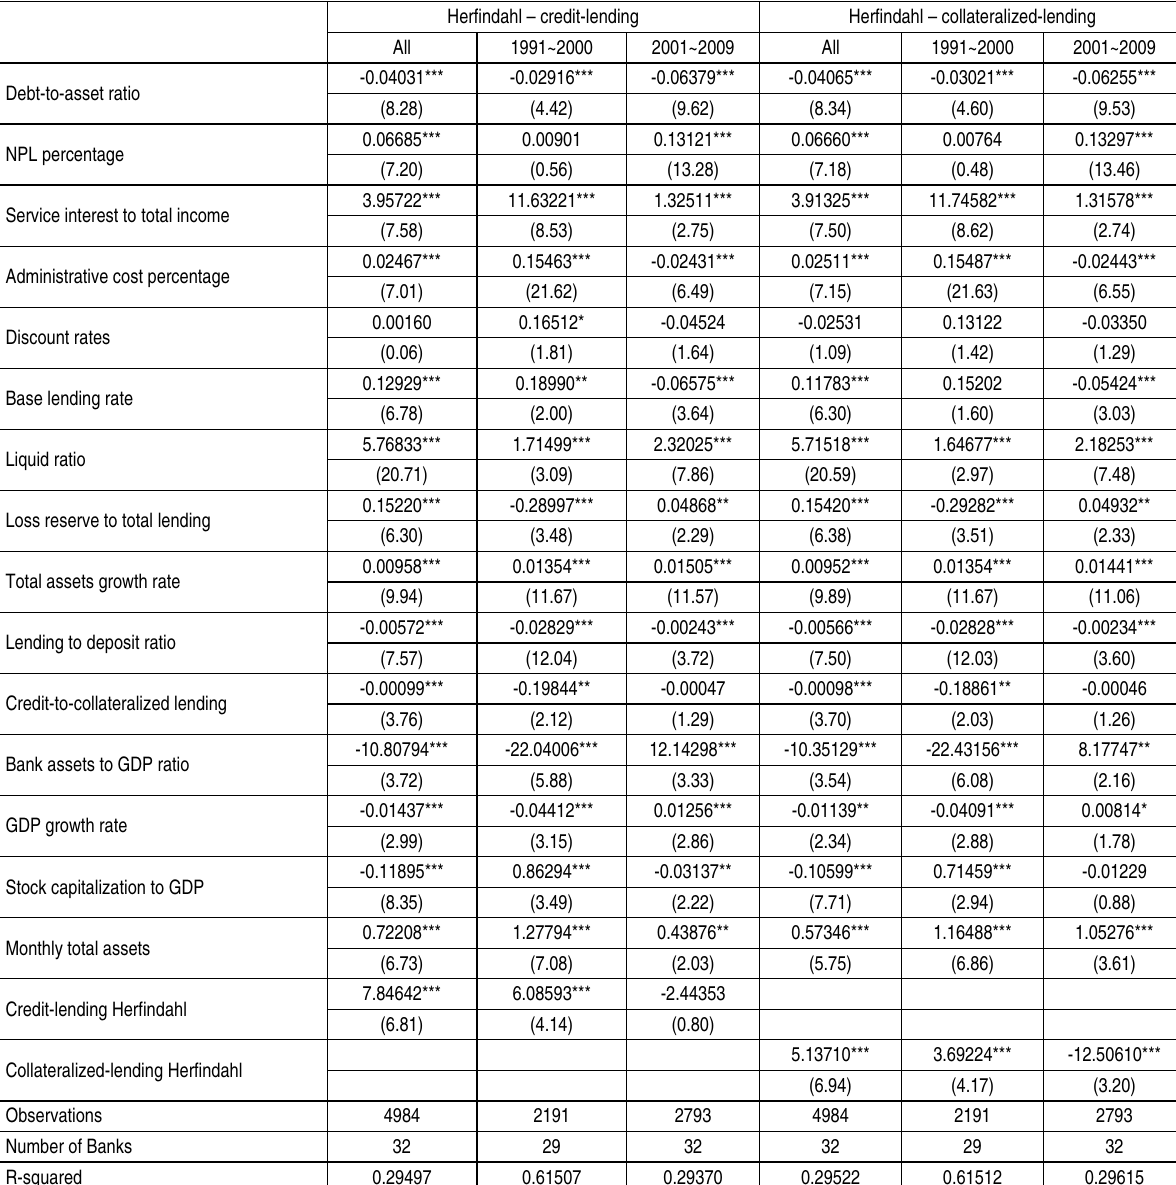
Table 10. Herfindahls based on credit lending and collateralized lending – adding macroeconomic